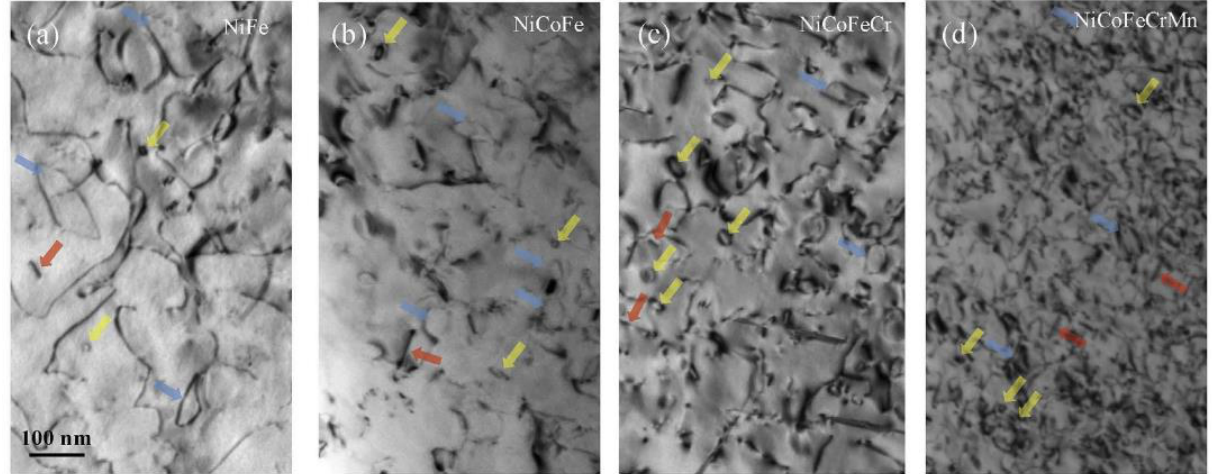
Figure 2. The dislocation loops evolution with the compositional complexity of composition in Ni-based CCAs, reprinted with permission from Ref. [26].